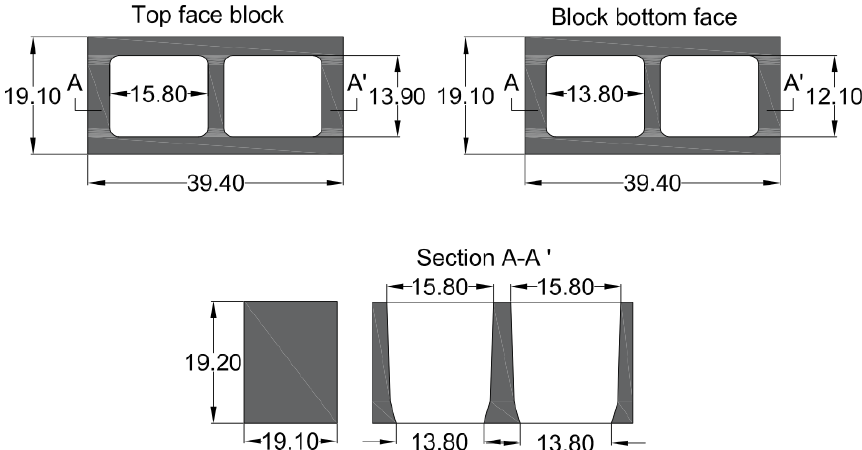
Figure 1. Dimensions (cm) of concrete blocks used in the tests.